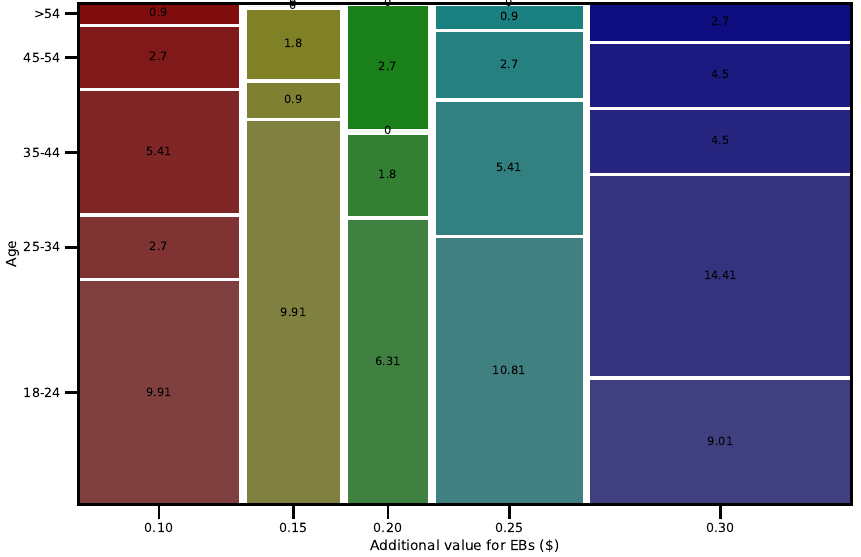
Figure 8. Mosaic plot of the willingness to pay an additional value for EBs based on